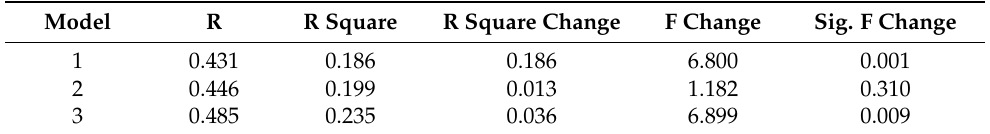
Table 2. Summary of the hierarchical multiple regression ( N = 155).